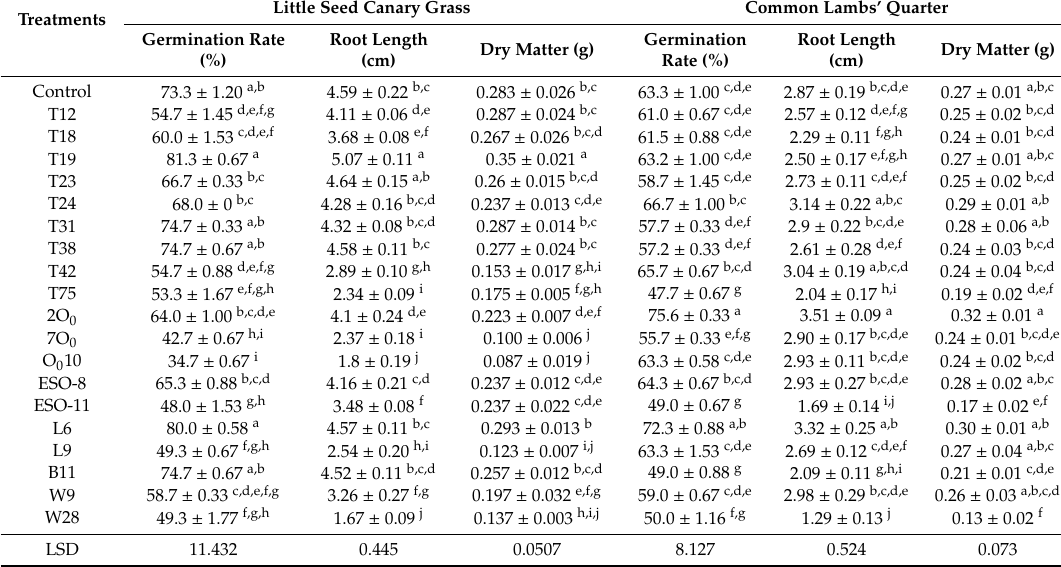
Table 4. The e ff ect of presumed allelopathic bacteria on the germination and seedling growth of little seed canary grass and common lambs’ quarter. Values sharing the same letter(s) in a column do not di ff er significantly from each other at p < 0.05. Values in a column indicate mean ± standard